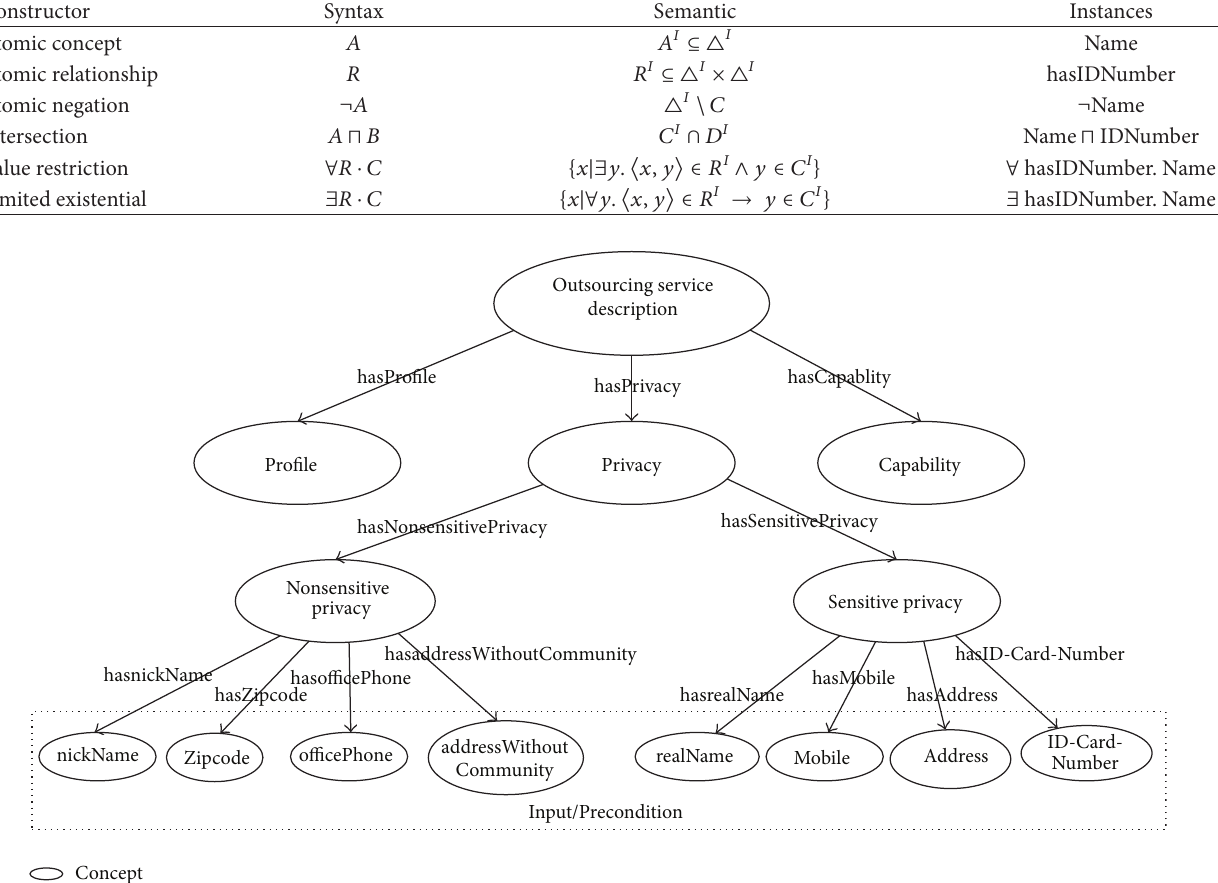
Figure 2: Privacy-oriented cloud service description